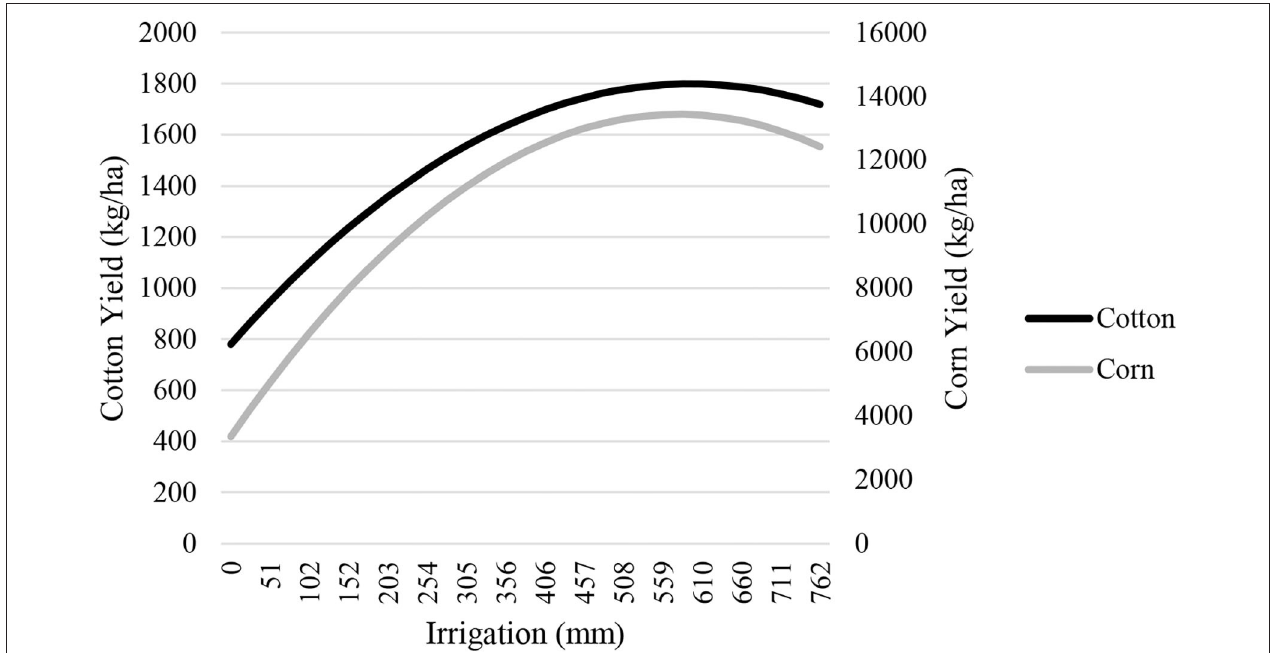
FIGURE 1 | Corn and Cotton Production Functions estimated using field-level data from the TAWC producers using LEPA